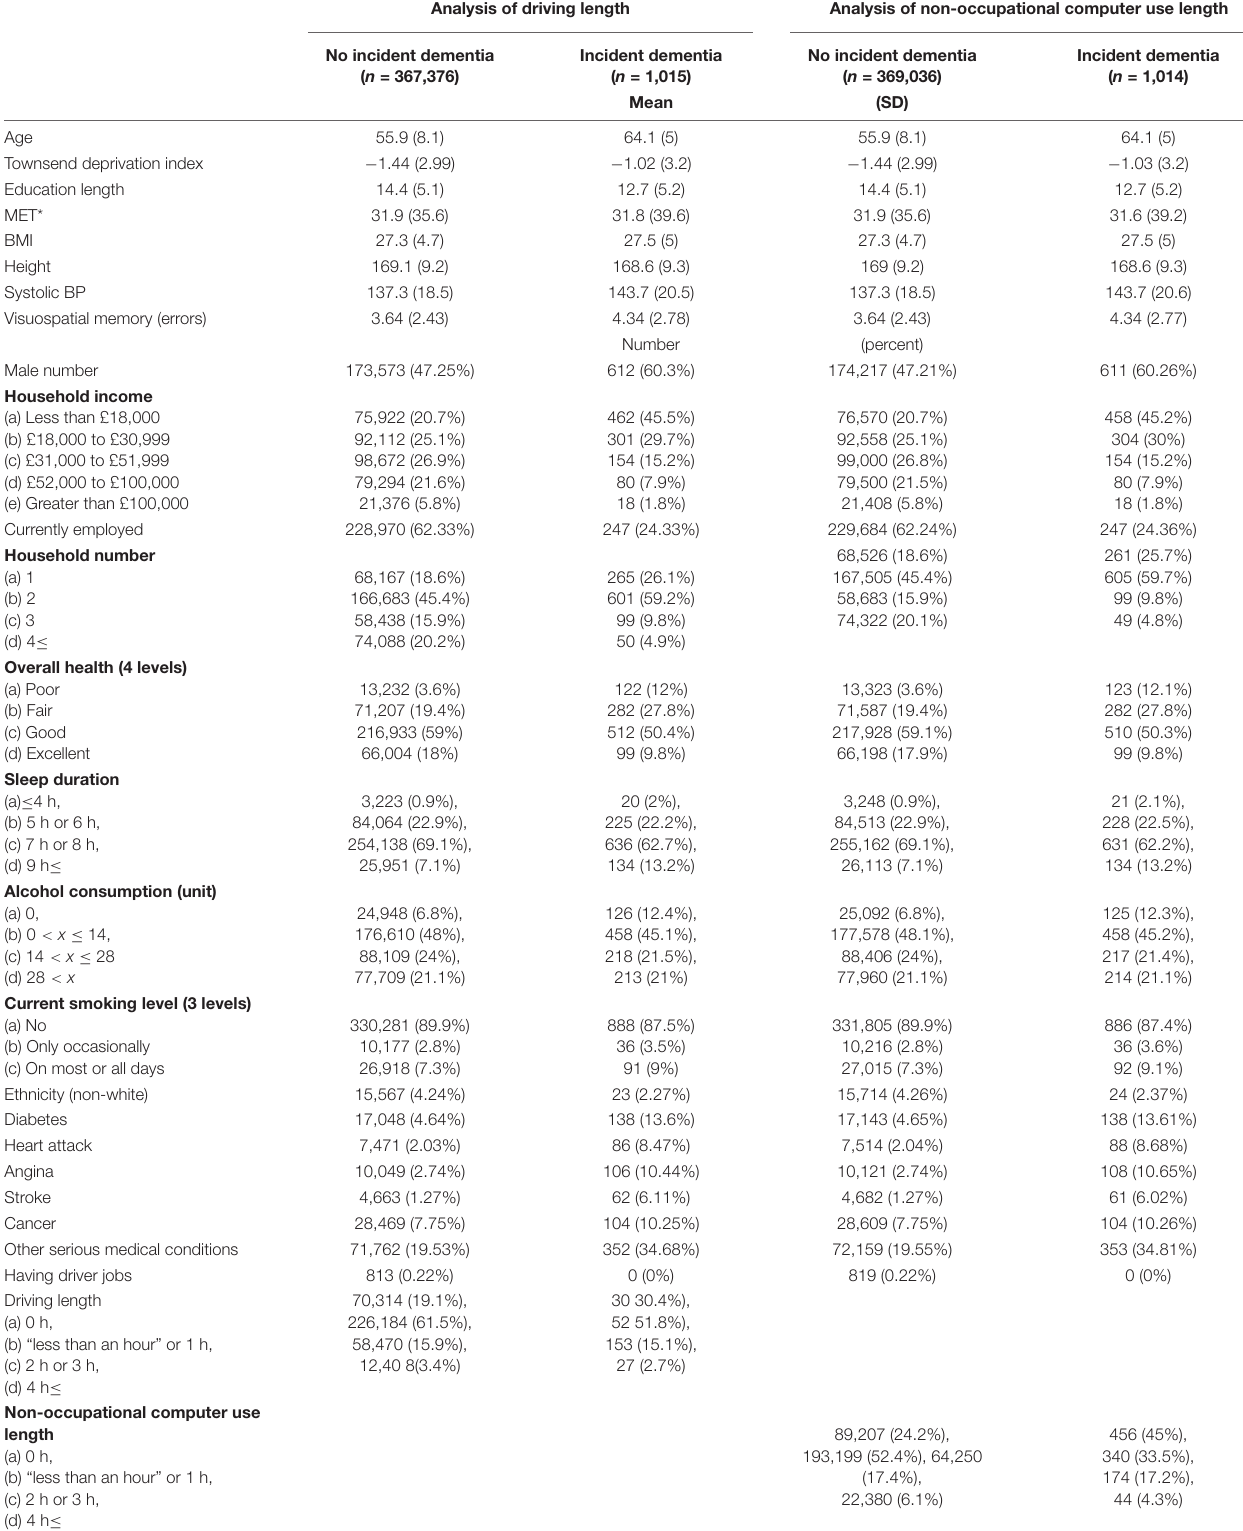
TABLE 1 | Baseline characteristics of participants with and without incident dementia